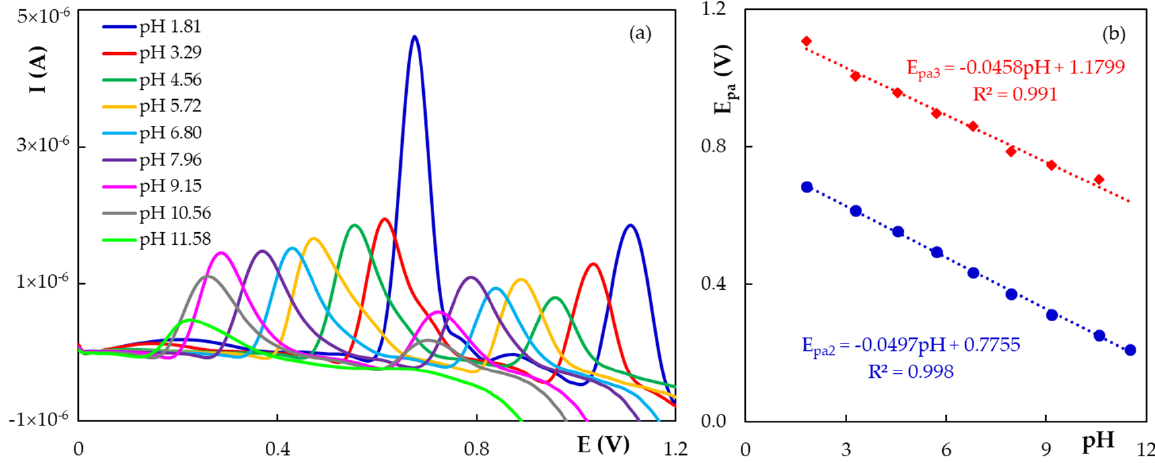
Figure 4. ( a ) Differential pulse voltammograms recorded at H type PGE for 5.00 × 10 − 5 mol/L HESP in BRB solutions with different pH values and ( b ) the corresponding E pa = f(pH) dependencies for the two HESP oxidation peaks.